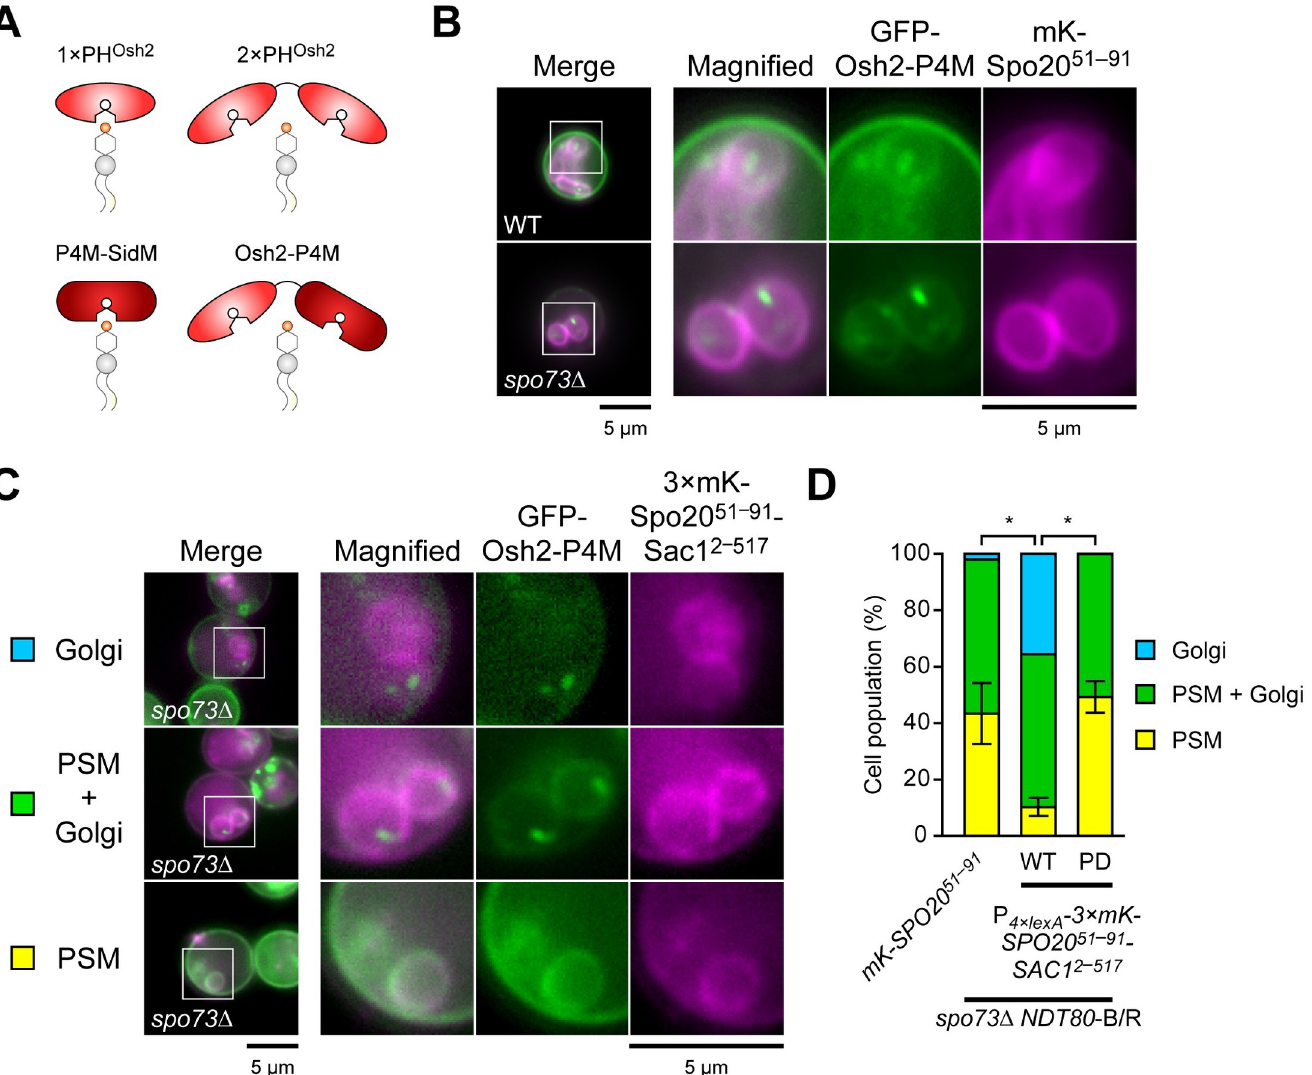
Fig 5. Changes in PI4P levels in the PSM can be detected using an improved PI4P biomarker. (A) Diagram of PI4P markers used in this study. See text for details. (B) Localization of GFP-Osh2-P4M in wild-type (TNY375) and spo73 Δ (TNY376) cells during PSM formation. (C) Representative localization of GFP-Osh2-P4M in spo73 Δ NDT80 -B/R cells producing 3 × mKate2-Spo20 51–91 -Sac1 2–517 during PSM formation. (D) Assessment of localization of GFP-Osh2-P4M in spo73 Δ NDT80 -B/R cells expressing indicated constructs. More than 100 cells were observed in three independent colonies of each condition. The bar graph shows mean ± SEM of the percent of the PSM population of each condition (N = 3). spo73 Δ NDT80 -B/R cells expressing GFP-Osh2-P4M and mKate2-Spo20 51–91 (TNY403), 3 × mKate2-Spo20 51–91 -Sac1 2–517 (TNY421), or 3 × mKate2-Spo20 51–91 -Sac1 2–517 -PD (TNY429) were observed. � , p < 0.05 (Tukey-Kramer test). mK,